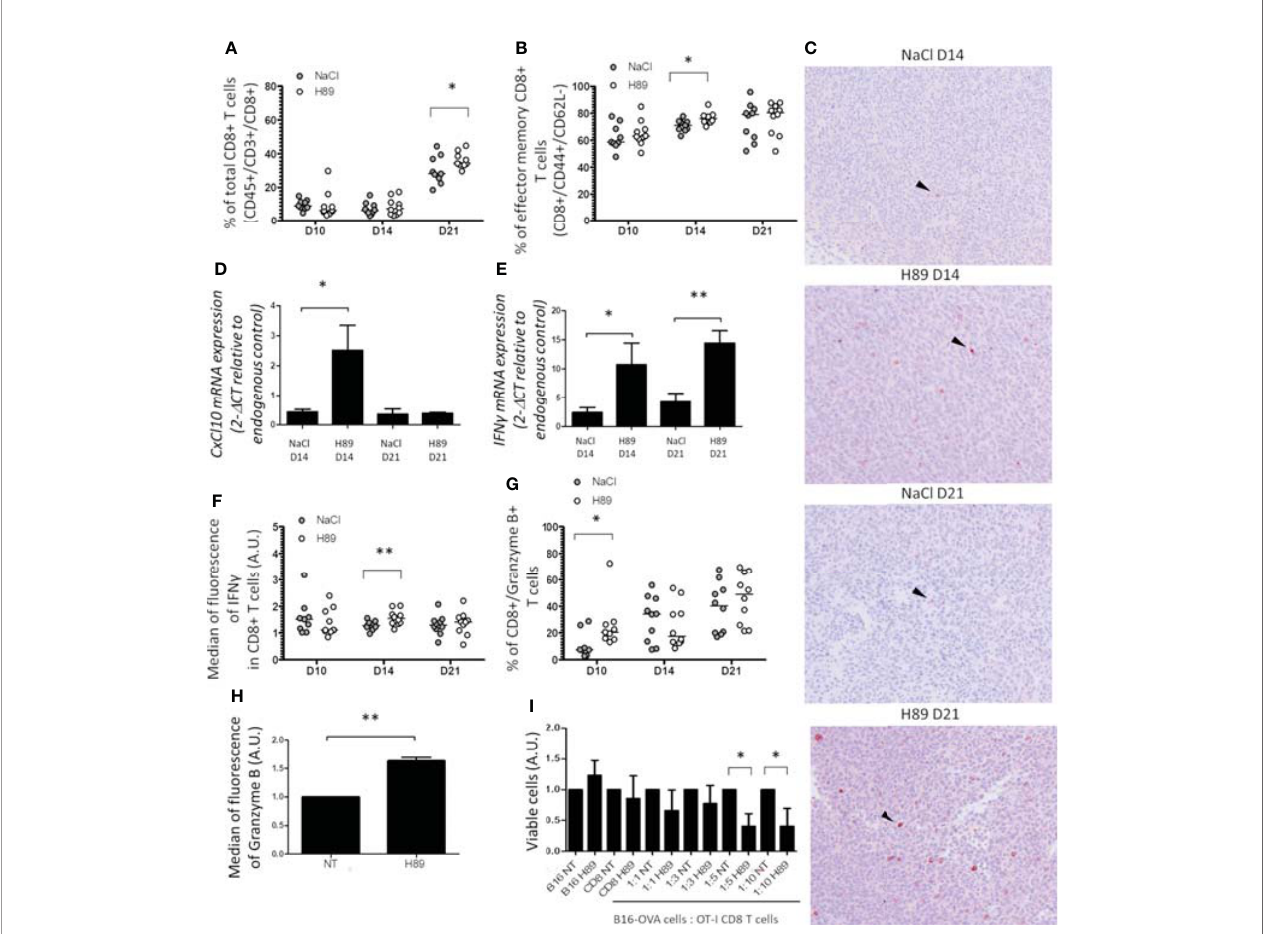
FIGURE 3 | H89 increases CD8 + TL tumor-in fi ltration, activation, and function. (A, B) Flow cytometry analysis ( n = 10 mice/group) of the intratumor in fi ltration of CD8 + T cells under H89 treatment on day 10 (D10), D14, and D21 after CT26 colon cancer cells injection (5 × 10 5 in s.c.). BALB/c mice were treated or not (NaCl) by H89 (10 mg/kg, i.p. administration twice a week). (C) IHC analysis on CT26 tumors after CD8 + T-cell labelling at D14 and D21 (representative images of 3 animals/group/time point). RT-qPCR analysis of CXCL10 (D) and IFN- g (E) expression at D14 and D21 after CT26 cancer cell injection ( n = 3 mice) and H89 treatment (10 mg/kg, i.p., NaCl in the control group). The results are presented as the mean of 2 − D CT values. (F, G) Flow cytometry analysis after intracellular labeling ( n = 10 mice/group) of IFN- g and granzyme B in intratumor CD8 + T cells at D10, D14, and D21 after CT26 colon cancer cell injection and H89 treatment (10 mg/kg, i.p., NaCl in the control group). (H) Flow cytometry analysis of granzyme B production of splenic CD8 + T cells ex vivo after H89 treatment (5 µM, 72 h) ( n = 3) and (I) cytotoxic assay using CD8 + T cells from OT-I mice cocultured with B16-OVA cells in vitro treated by H89 (5 µM, 48 h) ( n = 3). (H – I) The results are calculated as the mean of 2 − D CT values. Each control values (NT) are set at 1 arbitrary unit (A.U.), and H89-treated conditions are compared with the control. Statistically signi fi cant differences were determined by using a t -test: * p ≤ 0.05; ** p ≤